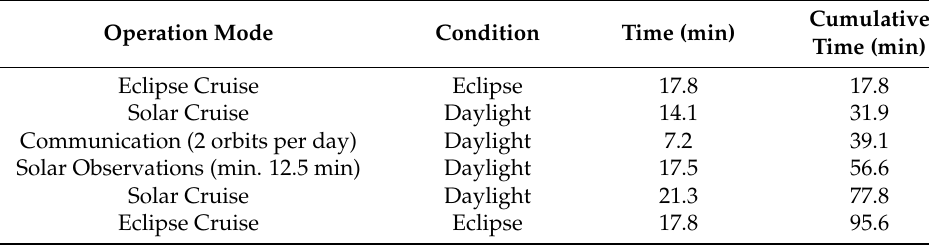
Table 4. Proposed payload operations cycle for an average noon/midnight SSO, commencing at the equator in